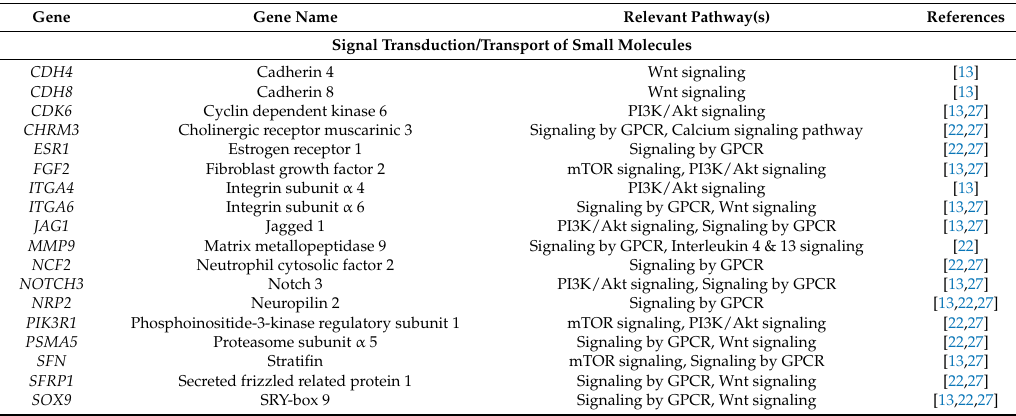
Table 2. Altered pathways in CF and associated